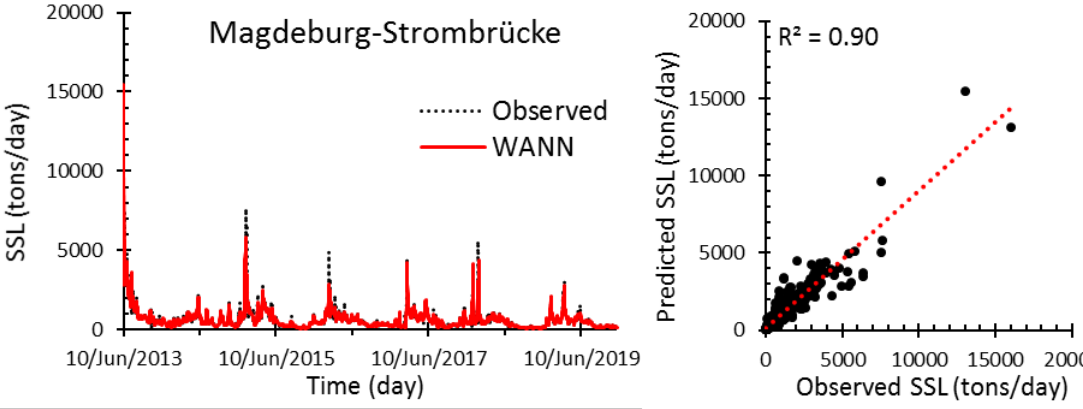
Figure 16. Observed versus predicted SSL of the best WANN model for the Magdeburg-Strombrücke station in a testing phase.